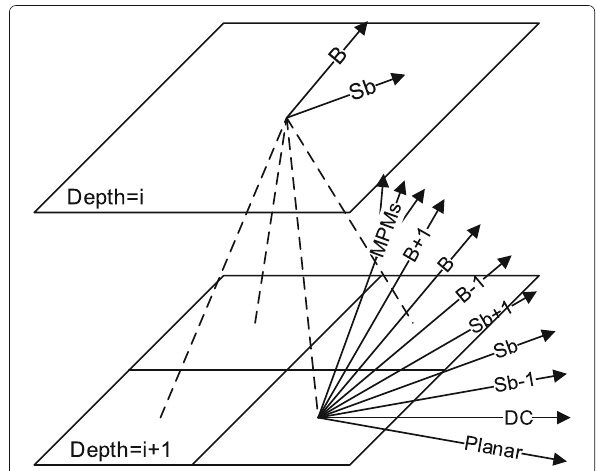
B and Sb represent the best and second best coding modes at depth level i . B n represents the best mode for the co- located PU at level i + 1. Figure 7 shows the possibility that B n is selected from various sets of coding modes when B and Sb are both directional modes. The statistical data was obtained from processing five video sequences.